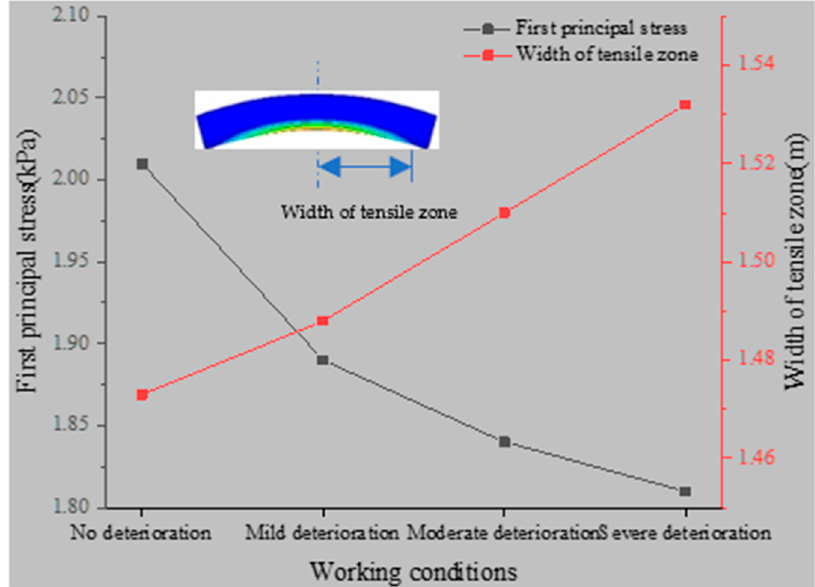
Figure 19. Stress and width of tensile zone after